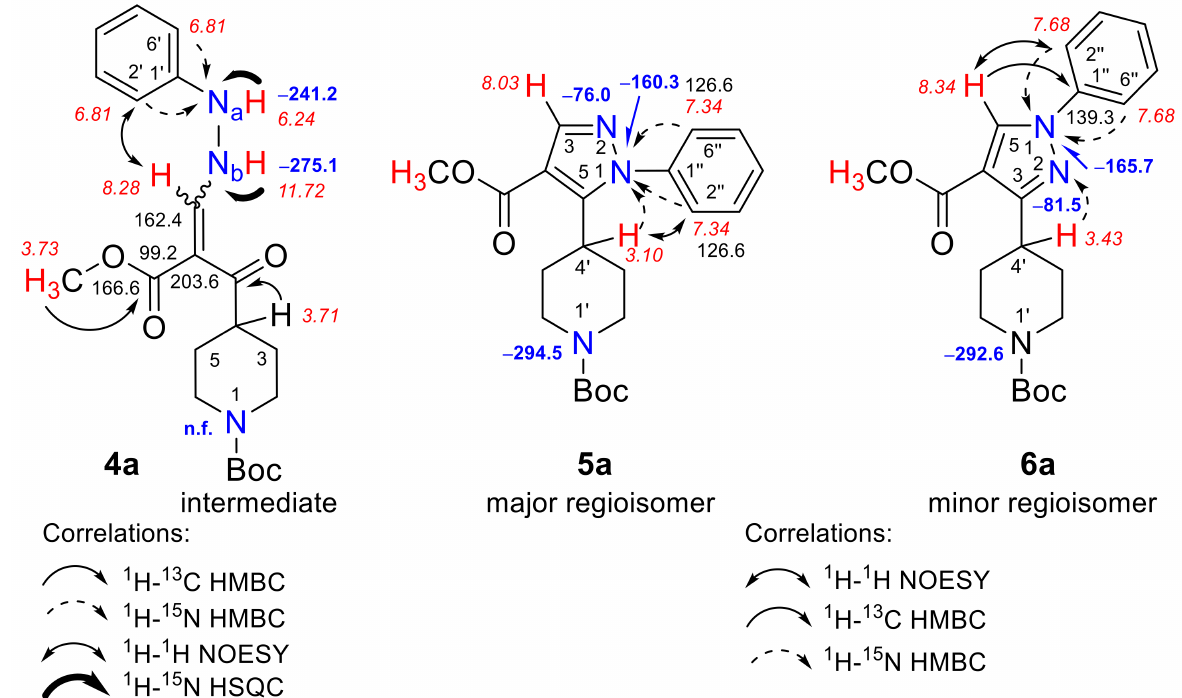
Figure 3. Relevant 1 H- 13 C HMBC, 1 H- 15 N HMBC, 1 H- 1 H NOESY, and 1 H- 15 N HSQC correlations and 1 H-NMR (ital- ics), 13 C-NMR, and 15 N-NMR (bold) chemical shifts of intermediate compounds 4a , 5a (major regioisomer), and 6a (minor